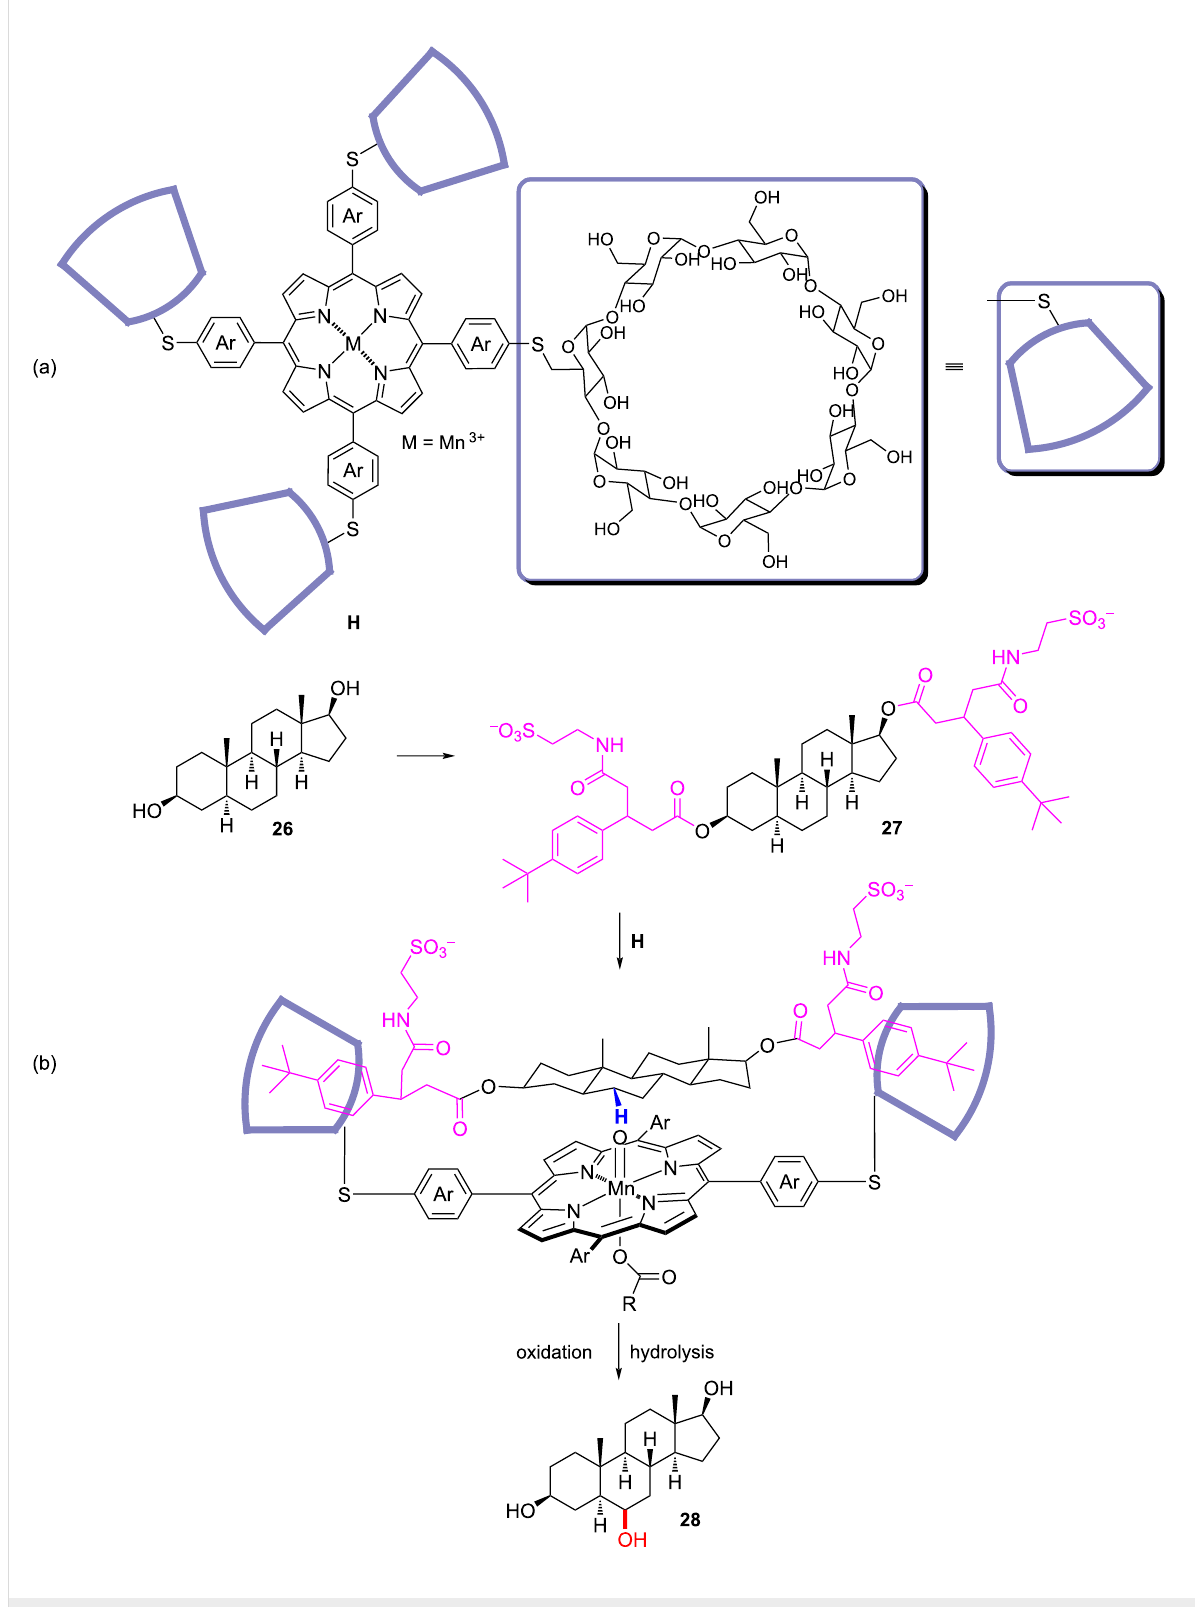
Figure 8: Site-selective oxidation of steroids using cyclodextrin as the anchoring